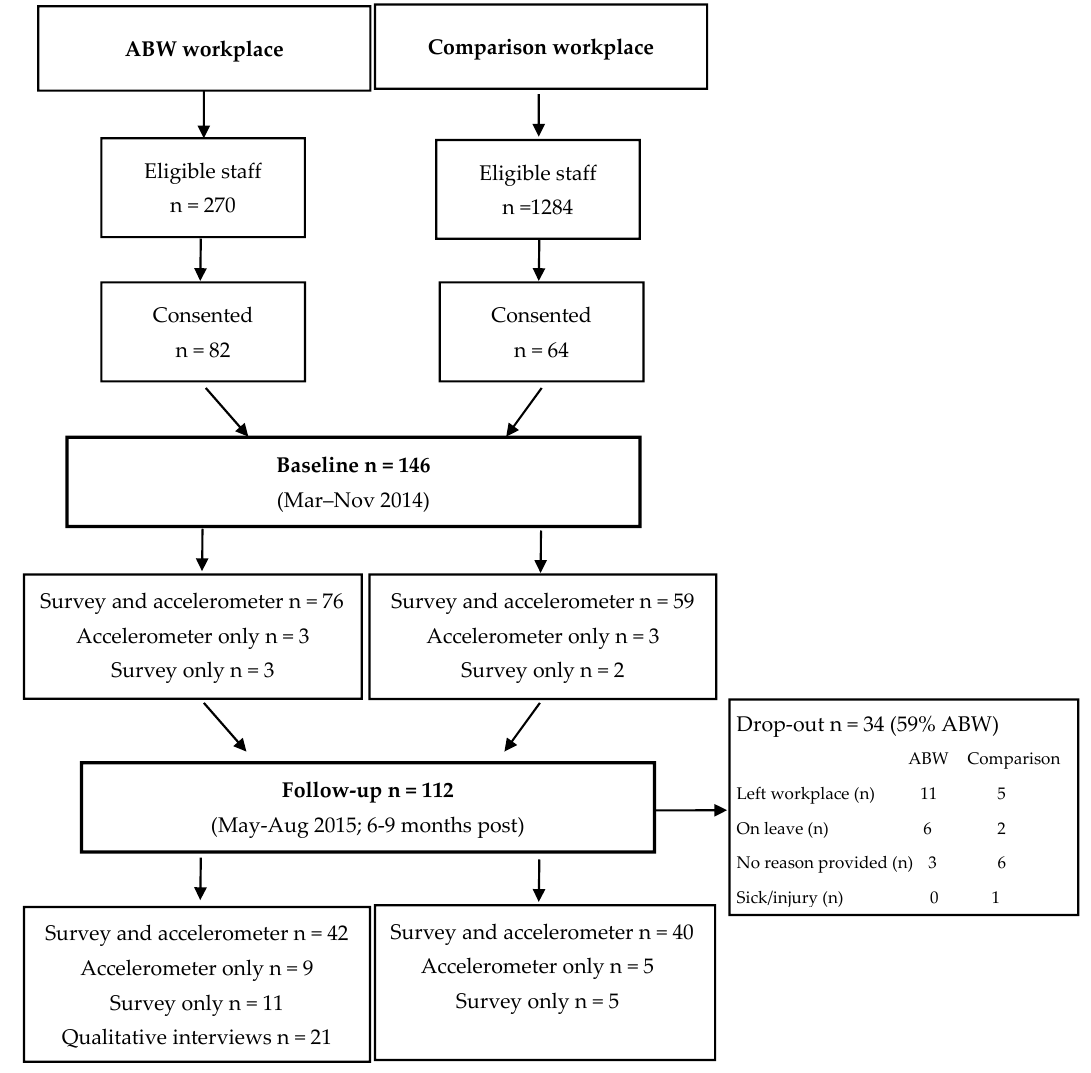
Figure 1. Participant flow and numbers through the study.